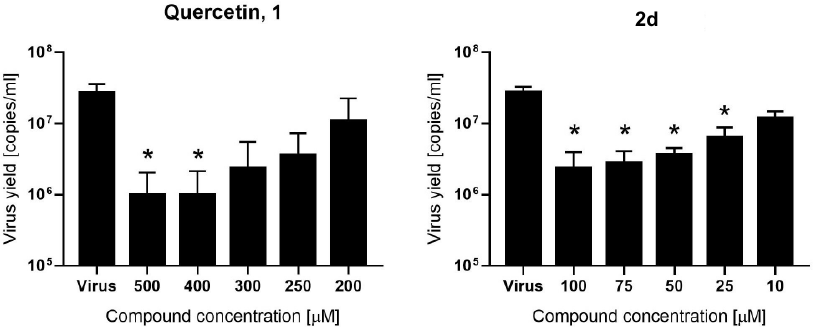
Figure 5. Inhibition of SARS-CoV-2 replication by quercetin (compound 1 ) and compound 2d . Virus replication was evaluated at the given compound concentrations using RT-qPCR and the data are presented as SARS-CoV-2 RNA copies per mL of the original sample. Bars show mean value ± SEM from three independent experiments. The significance level (* p < 0.05) is denoted with an asterisk in the graph.